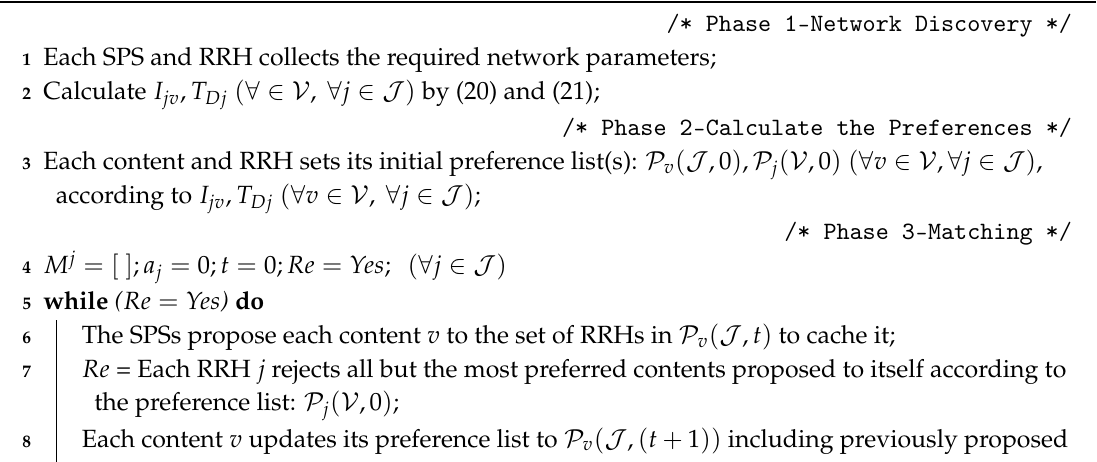
Algorithm 1: Cache Content Placement